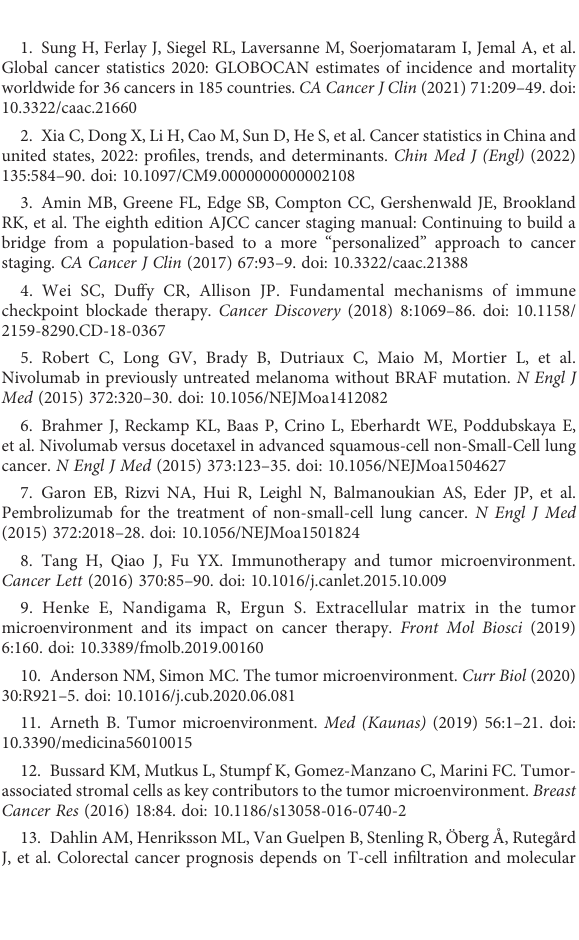
SUPPLEMENTARY FIGURE 4 Difference of cluster frequencies between high and low IEScore groups. (A). Boxplots showing the difference offrequencies in 31 immune clusters between high and low IRScore groups. SUPPLEMENTARY FIGURE 5 Transcriptomic pro fi les of CD103 + CD39 + T cells. (A). Violin plot showing the expression of CD69, CD4, CD8A and CD8B. (B) . Heatmap of CD4 + and CD8 + T cells, with 16 main clusters identi fi ed, each containing a unique set of signature genes. (C) . Volcano plot of differentially expressed genes between CD4 + DP and DN cells. (D) . Enrichment plot for the curated gene signature in CD4 + TILs by GSEA. (E, F) . Gene set enrichment analysis of Cancer Hallmark gene sets identi fi ed signi fi cantly enriched pathways in CD8 + (E) and CD4 + (F) DP and DN cells. SUPPLEMENTARY FIGURE 6 Prediction of CD45 + CD3 + CD103 + CD39 + phenotype to immunotherapy. (A, D, G). Violin plots showing the difference of NES (CD45 + CD3 + CD103 + CD39 + (A) , CD45 + CD3 + CD4 + CD103 + CD39 + (D) and CD45 + CD3 + CD8 + CD103 + CD39 + (G) ) between CR/PR/SD and PD in IMvigor210 cohort. (B, E, H) . Composition of patients ’ responses to PD-L1 inhibitor treatment between M1 and M2 in IMvigor210 cohort ( (B) : P -value = 0.010; (E) : P -value = 0.019; (H) : P -value=0.035,Fisher ’ sexacttest). (C,F,I) .WaterfallplotsillustratingNES (CD45 + CD3 + CD103 + CD39 + (C) , CD45 + CD3 + CD4 + CD103 + CD39 + (F) and CD45 + CD3 + CD8 + CD103 + CD39 + (I) ) according to immunotherapeutic responses in IMvigor210